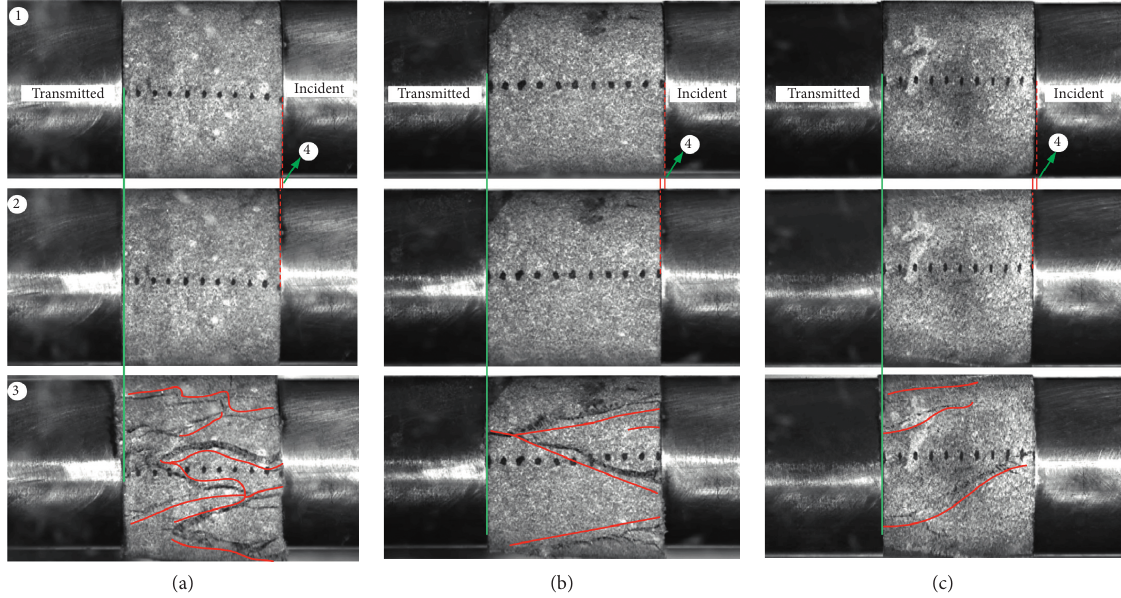
Figure 10: Effect of different brittleness and loading strain rates on the macroscopic failure modes of the testing samples. (a, b) The dynamic failure process of samples with brittleness index of 0.88 and 0.73 at a loading strain rate of 134 s − 1 , respectively. (c) The dynamic failure process of the sample with a brittleness index of 0.73 at a loading strain rate of 93 s − 1 . (a) BI 3 � 0.88; _ ε � 134 s − 1 . (b) BI 3 � 0.73; _